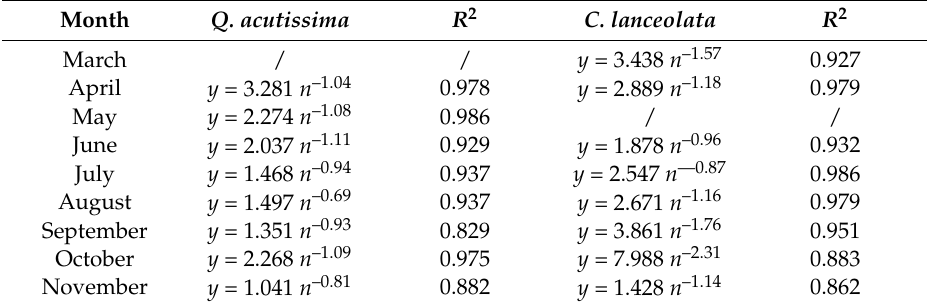
Table 3. The change trends of nocturnal sap flow density from sunset to sunrise.